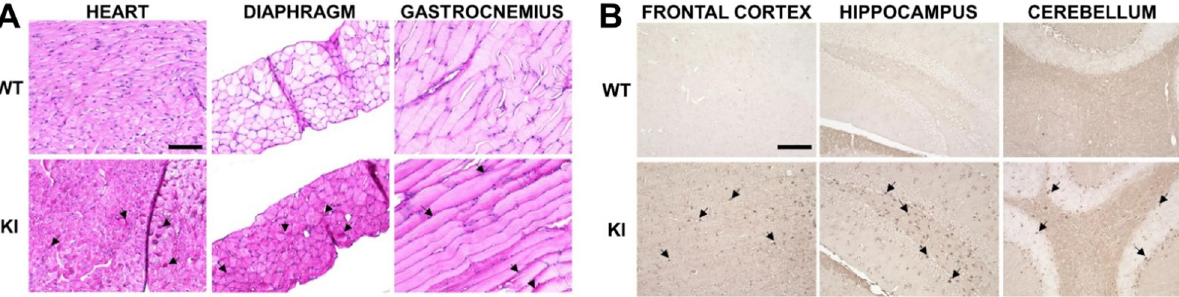
Figure 4. Tissue pathology in Gaa em1935C > A KI mice showing glycogen storage in muscles and lysosomal abnormality in brains. ( A ) Representative bright-field images of heart, diaphragm, and gastrocnemius sections from 3-month-old WT and KI mice, stained with hematoxylin/PAS. Areas of abnormal glycogen accumulation (arrowheads) in cardiac and skeletal muscle tissues were observed in KI mice compared to WT mice (top). ( B ) Immunohistostaining with mouse anti-LAMP1 antibody showing increased cell body staining (arrowheads) in frontal and hippocampal neurons and Purkinje cells of KI mice from all three representative brain areas (frontal cortex, hippocampus and cerebellum). Scale bar represents 100